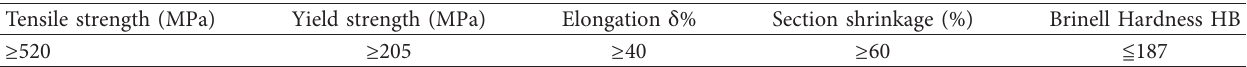
Table 2: Mechanical performance of 304 stainless wire.